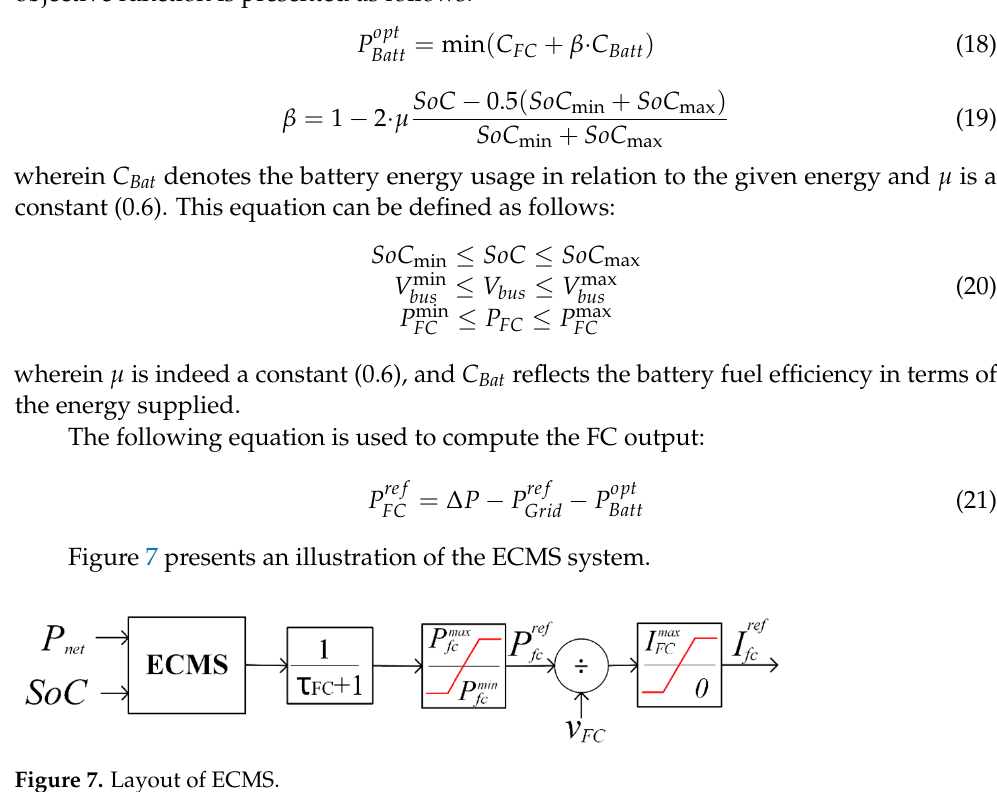
Figure 7. Layout of ECMS.